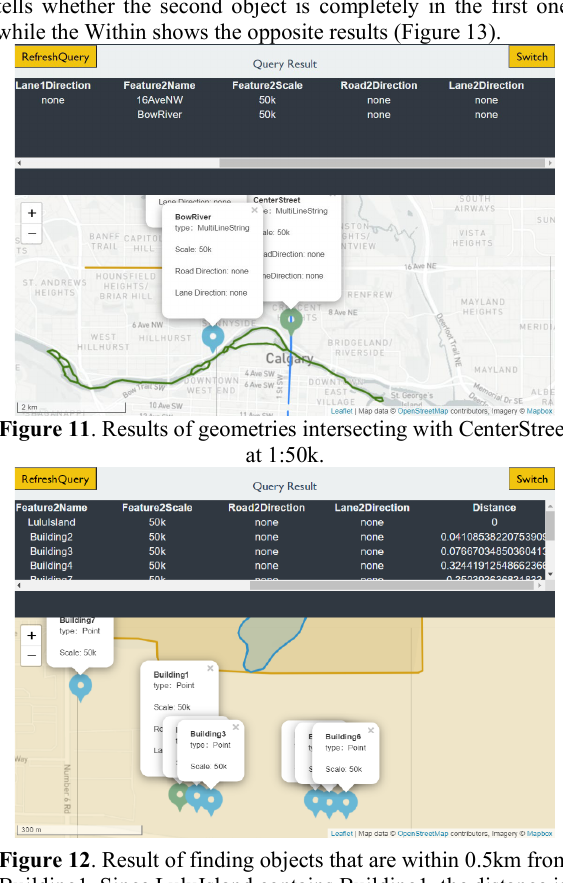
Figure 10 . (a) Result of Zoom out from Railway at 1:5M. (b) Zoom in from Port Mann Bridge at 1:250k and receive an “uneven” result. (c) Navigating from the Layer Node CityCenter at 1:250k to 1:50k.